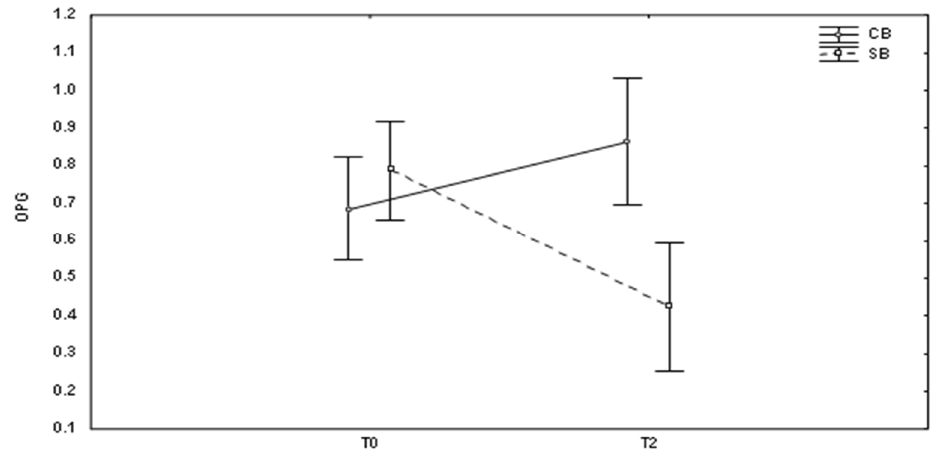
Figure 1. Changes in OPG (mean ± SD) levels at different times (T0, baseline; T2, after 2 months of the treatment) in patients with conventional brackets (CB) and self-ligating brackets (SB).